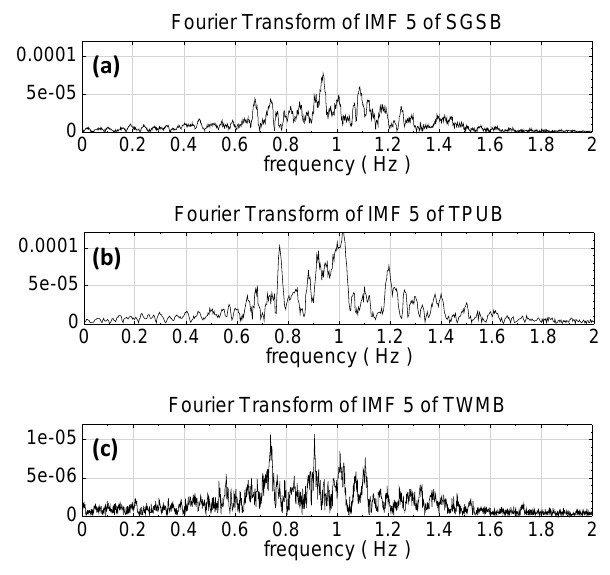
Figure 9 The IMF 5 Fourier transform for stations (a) SGSB, (b) TPUB, and (c) Fig. 9. The IMF 5 Fourier transform for stations (a) SGSB, (b) TWMB. TPUB, and (c)